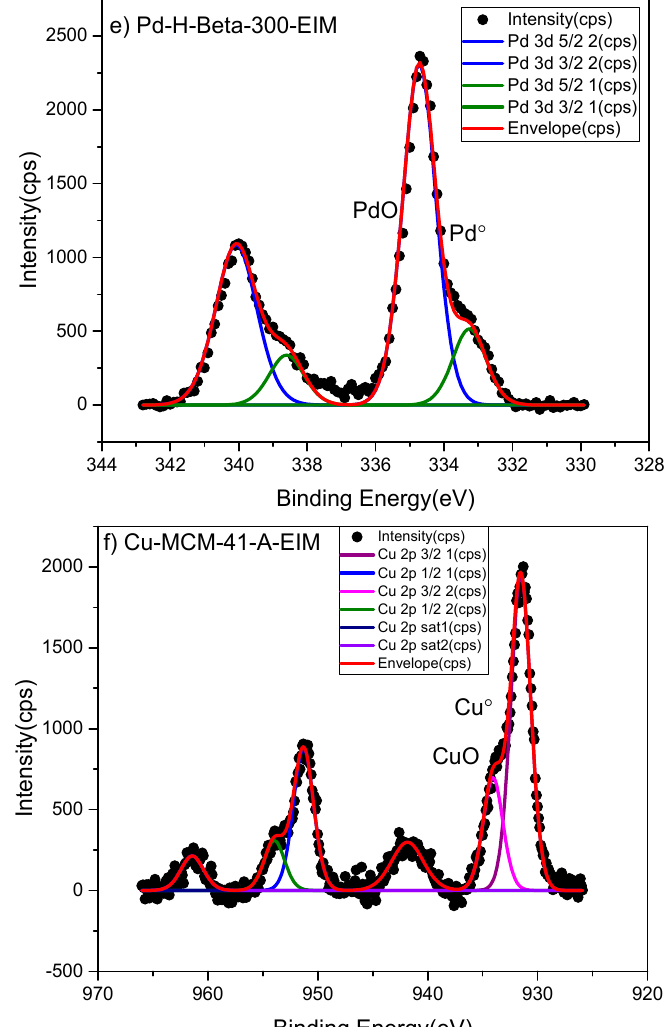
Figure 3. X-ray photoelectron spectroscopy (XPS) spectra of ( a ) Pt-MCM-41-IS, ( b ) Ru-MCM-41-IS, ( c ) Pd-H-Y-12-EIM, ( d ) Pt-H-Y-12-EIM, ( e ) Pd-H-Beta-300-EIM and ( f ) Cu-MCM-41-A-EIM catalysts.